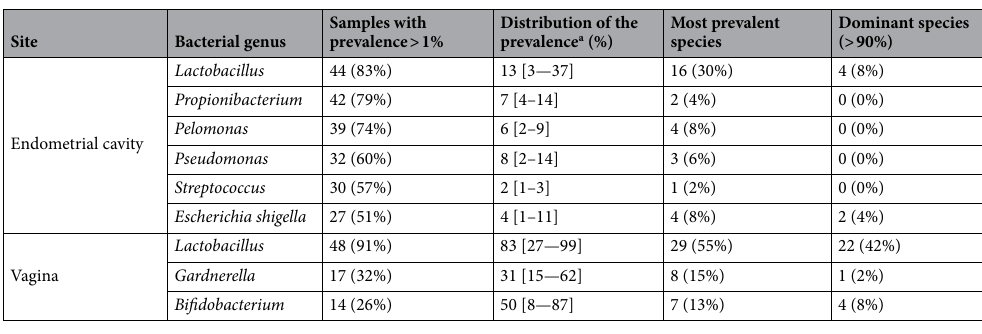
Table 2. Abundance of the most prevalent bacteria in endometrial and vaginal microbiota. For the most common bacteria, the table illustrates the frequency of specimen clearly demonstrating its presence (prevalence > 1%), their Median [interquartile range] distribution, when they are the prevalent species (“Most prevalent species”) and the frequency of specimen showing a strong dominance of that species (“Dominant species”, i.e., when the species represented > 90% of the detected bacteria). Data is reported as number (%) or Median [interquartile range], as appropriate. a This data refers exclusively to samples showing a prevalence of the genera above 1%.